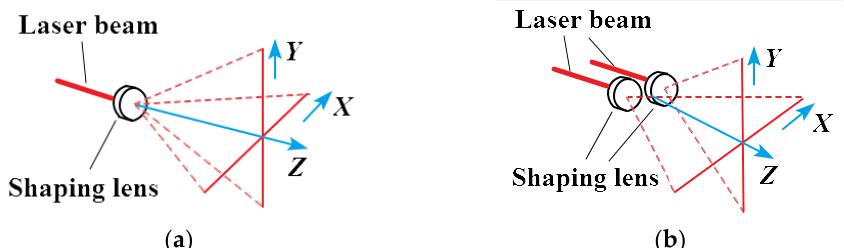
Figure 1. Two forms of cross laser-pattern. ( a ) Cross laser formed of a single light source. ( b ) Cross laser formed of two laser sources.